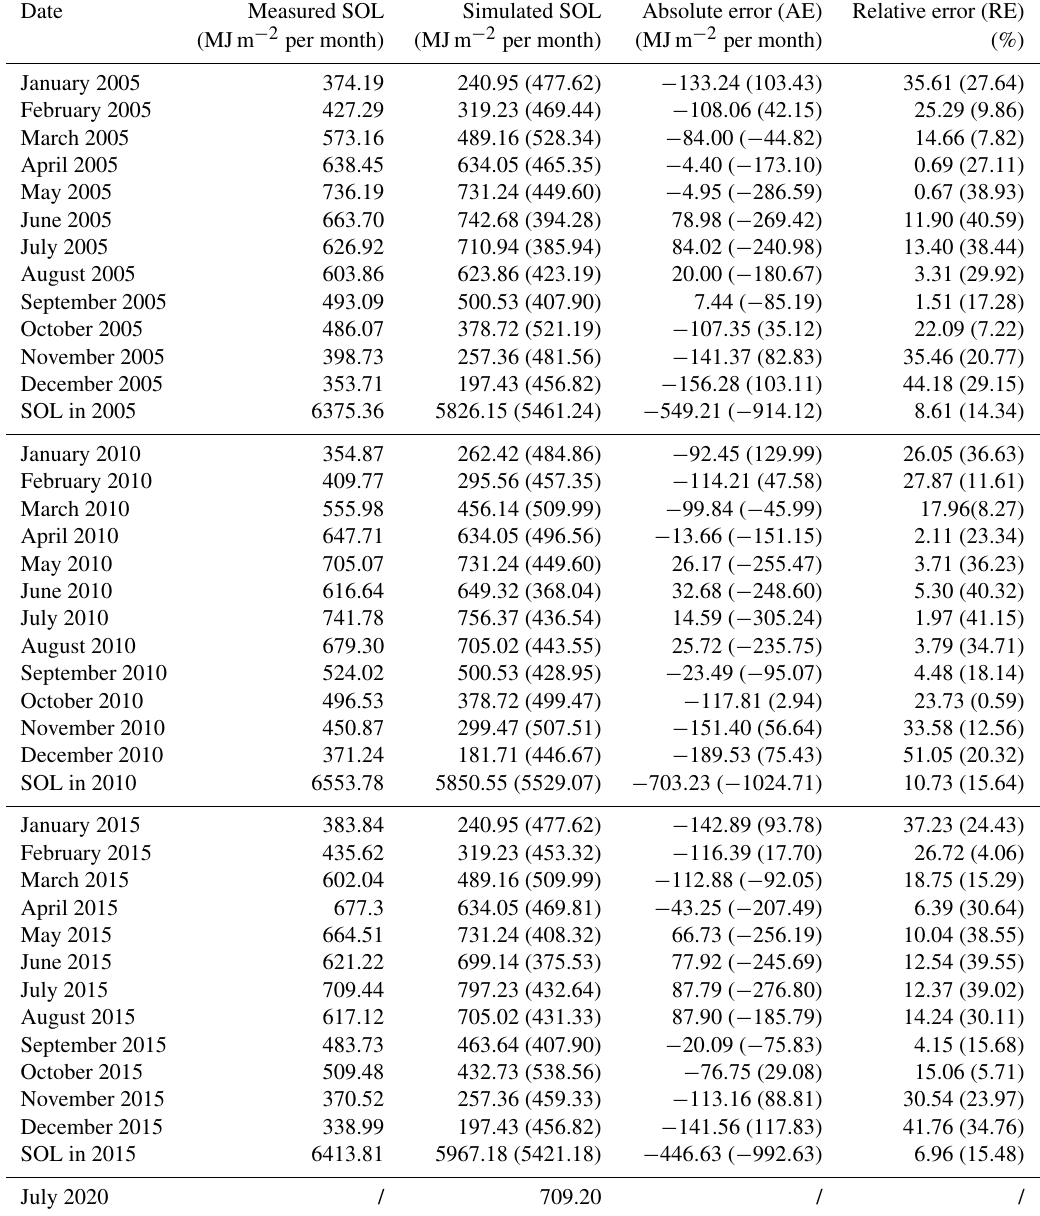
Table 3. Measured versus simulated